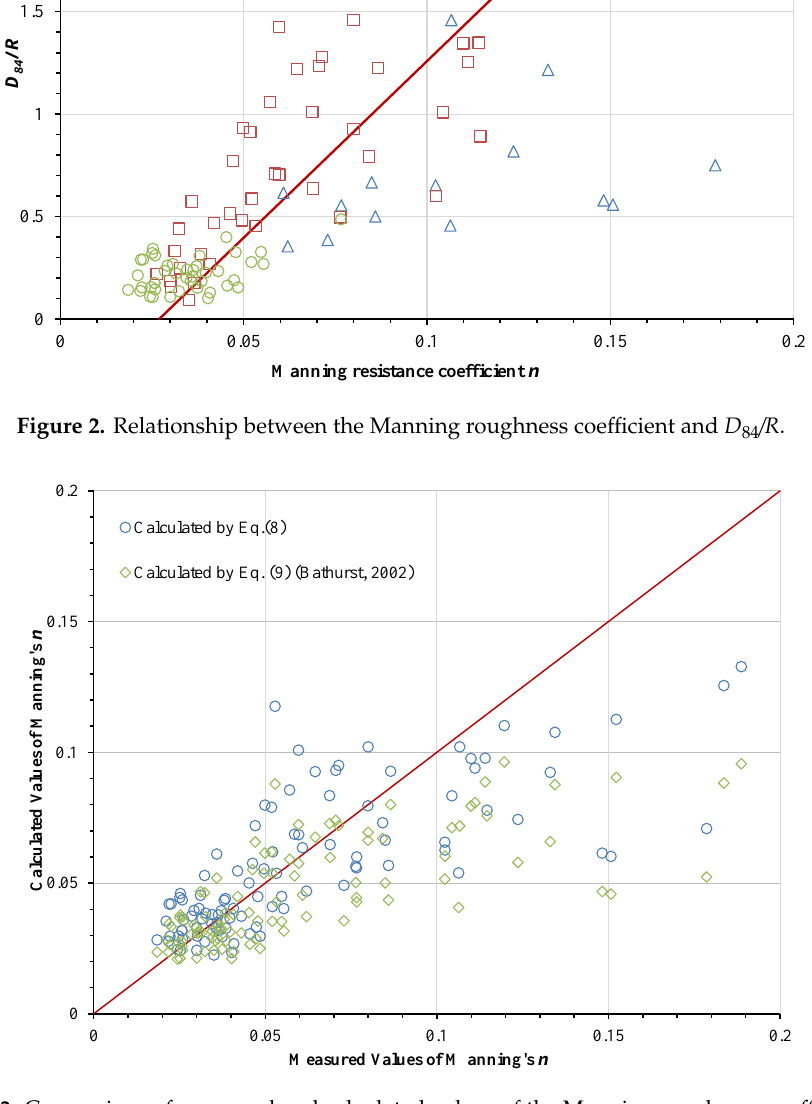
Figure 3. Comparison of measured and calculated values of the Manning roughness coefficient.